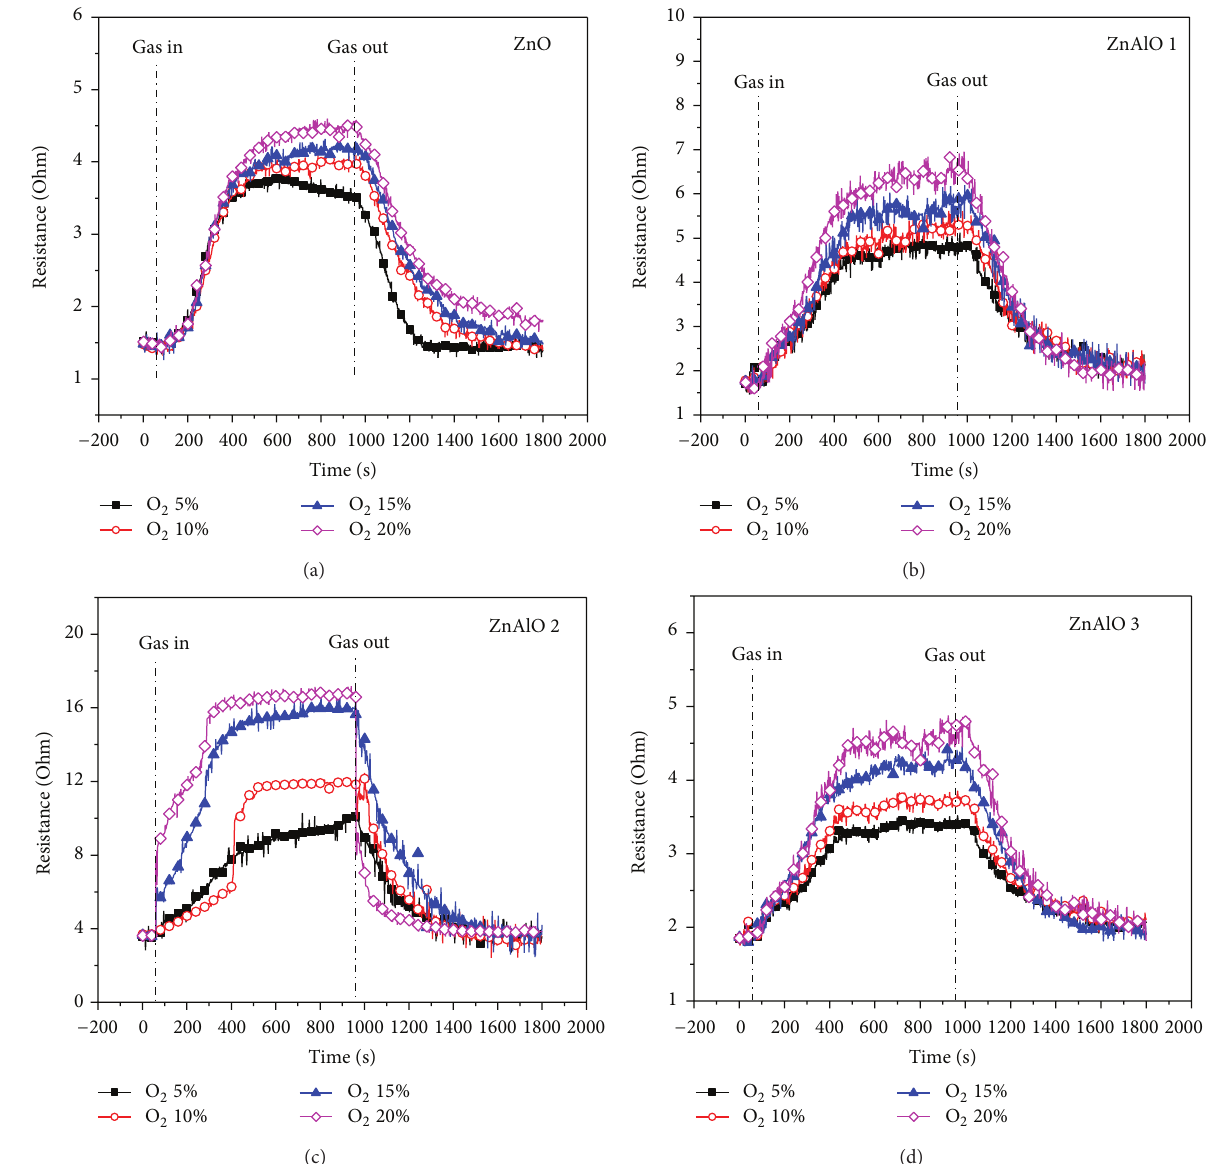
Figure 4: The effect of aluminum content on the resistance of zinc aluminum oxide gas sensor upon exposure to the various concentrations of oxygen at an operating temperature of 150 ∘ C.